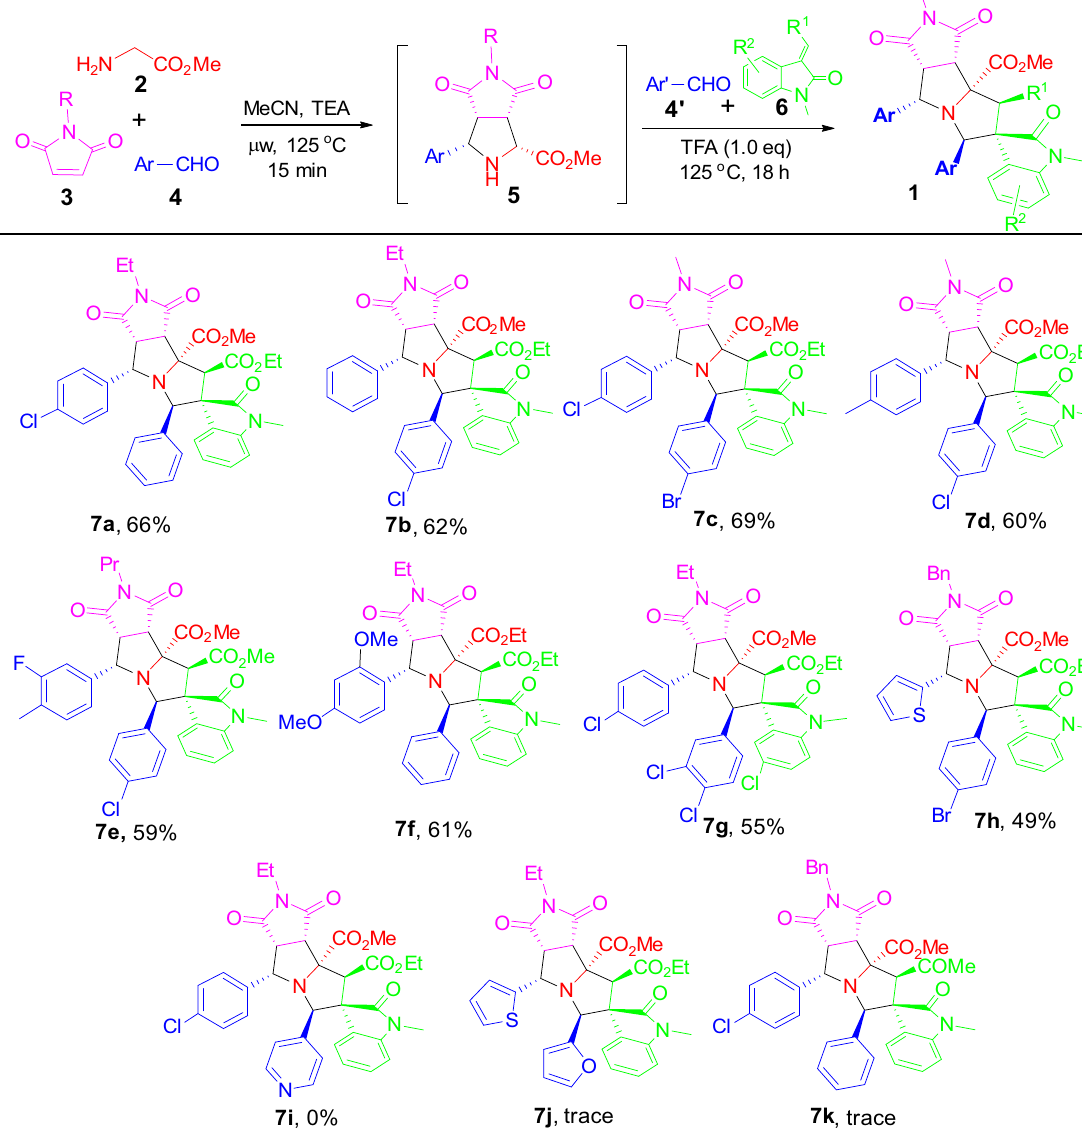
Figure 3: Double [ 3 + 2 ] cycloadditions using di ff erent aldehydes 4 and 4 ′ . Isolated yield: reaction conditions are same as in Table 1, entry